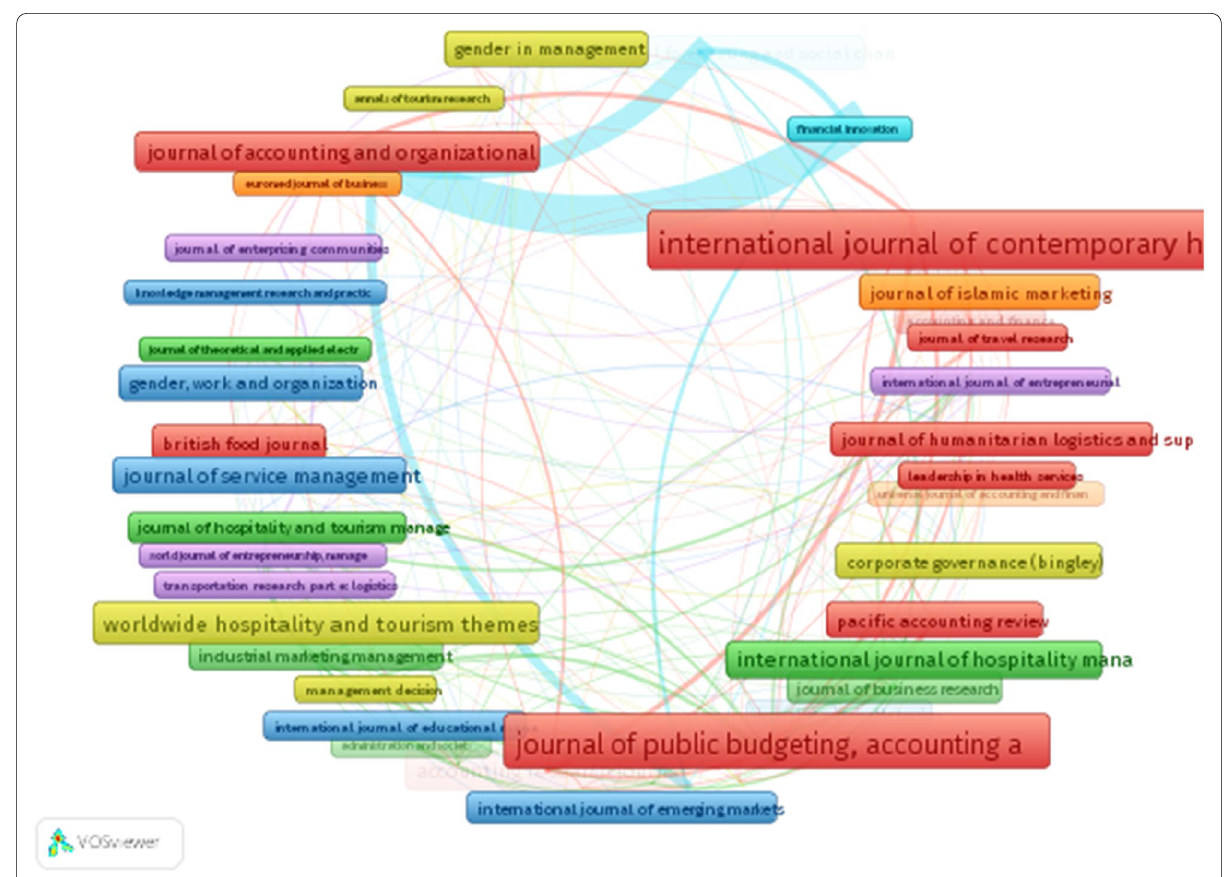
Fig. 7 Network visualization of the bibliographic coupling of